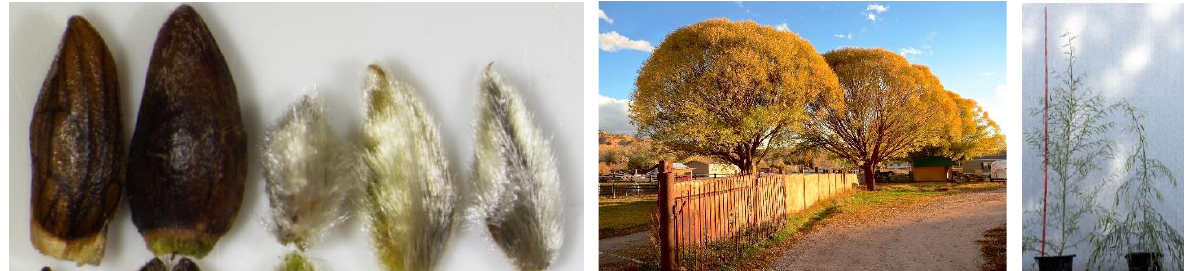
Figure 5. Bud scales and pubescent outermost cataphylls of S. babylonica var. matsudana ‘Umbraculifera’ ( left ) . A unique dense subglobose crown of S. babylonica var. matsudana ‘Umbraculifera’ ( center ) (photos by M. Dodge). Upright habit of S. babylonica var. matsudana ‘Umbraculifera’ ( left ) and pendulous habit of S. babylonica ’Babylon’ ( right ) visible during their first year of growth ( right ). The color of thin branches and branchlets of ‘Umbraculifera’ ranges from yellow-greenish to purple-brownish (the upper side of the branches exposed to the sun gets tanned, gaining purple color). Mature branches and leaves are glabrous. Buds blunt at the apex ( S. fragilis ‘Bullata’ has acuminate buds). Outermost cataphylls inside the buds densely pubescent as in S. babylonica var. matsudana (glabrous S. fragilis ‘Bullata’) (Figure 5). Young leaves are reddish; unfolding leaves are densely pubescent on the upper side, rarely on the lower side and mainly along the central vein. Stipules are large, with rolled up edges and sparse hairs. Stipule attachment point, as in S. fragilis ‘Bullata’, is on the side of the lower third part of the stipule (in S. babylonica var. babylon —at the base) (Figure 6). Bracts glabrous is acuminate. Ovaries sessile with a very short stipe. Nectary occurred as one or rarely two.